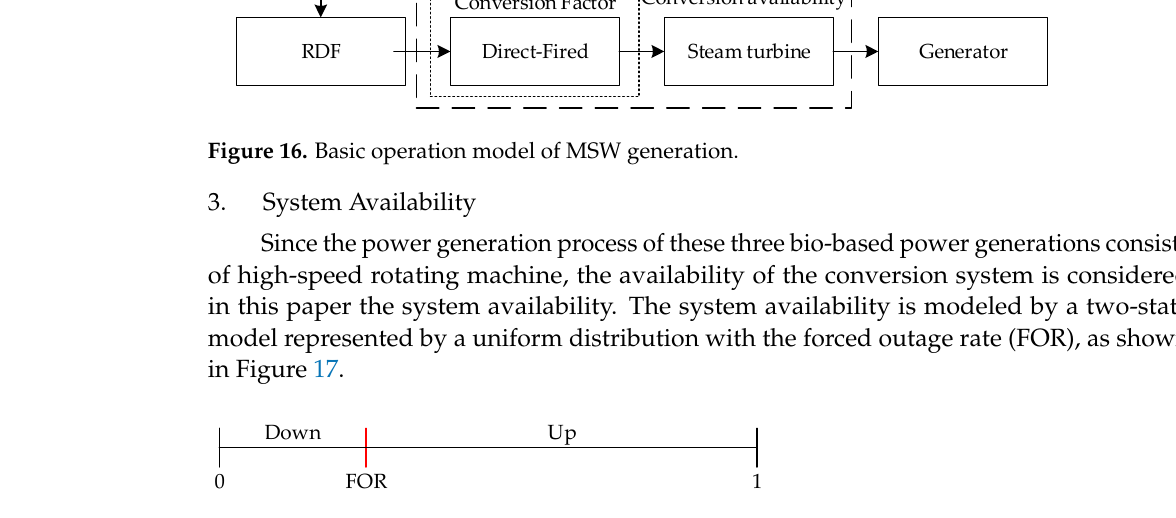
Figure 17. Availability of system two-state model.